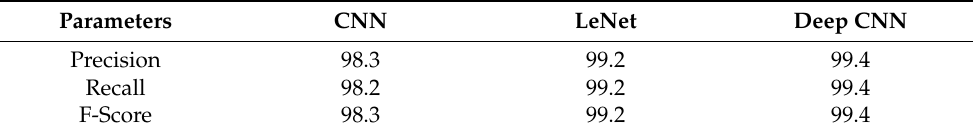
Figure 11. Loss Comparison of CNN, LeNet, and the Proposed DCNN on the Pashto Charac- ters Dataset. Table 3. Precision, Recall, and F 1 -Score Comparison of CNN, LeNet, and Deep CNN Models of the Pashto Character Dataset.